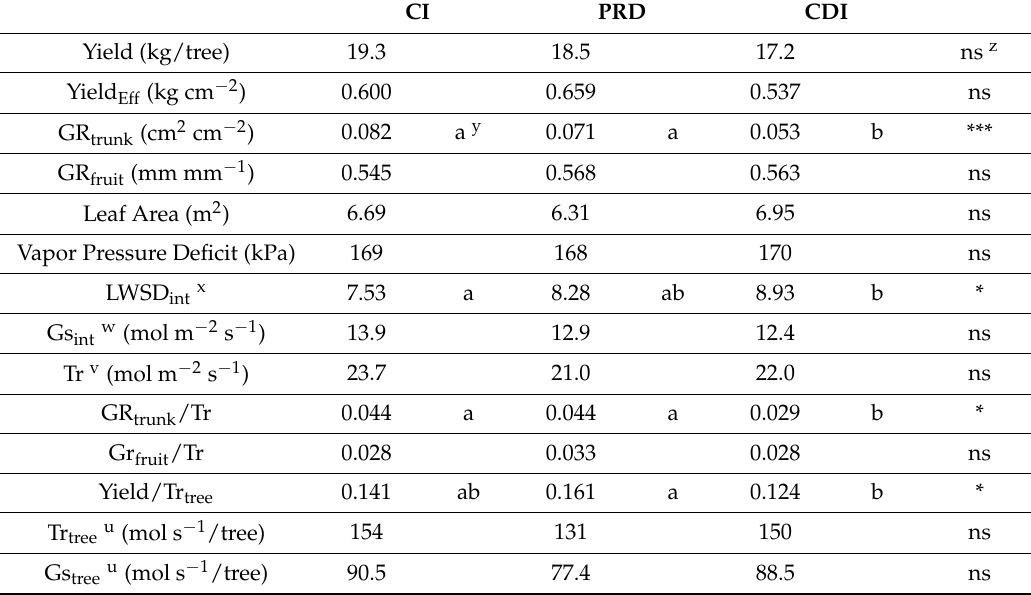
Table 2. Yield, growth (GR), and water-use related variables in ‘Gala’ apple trees under conventional irrigation (CI), partial root zone drying (PRD), and continuous deficit irrigation (CDI). CI PRD